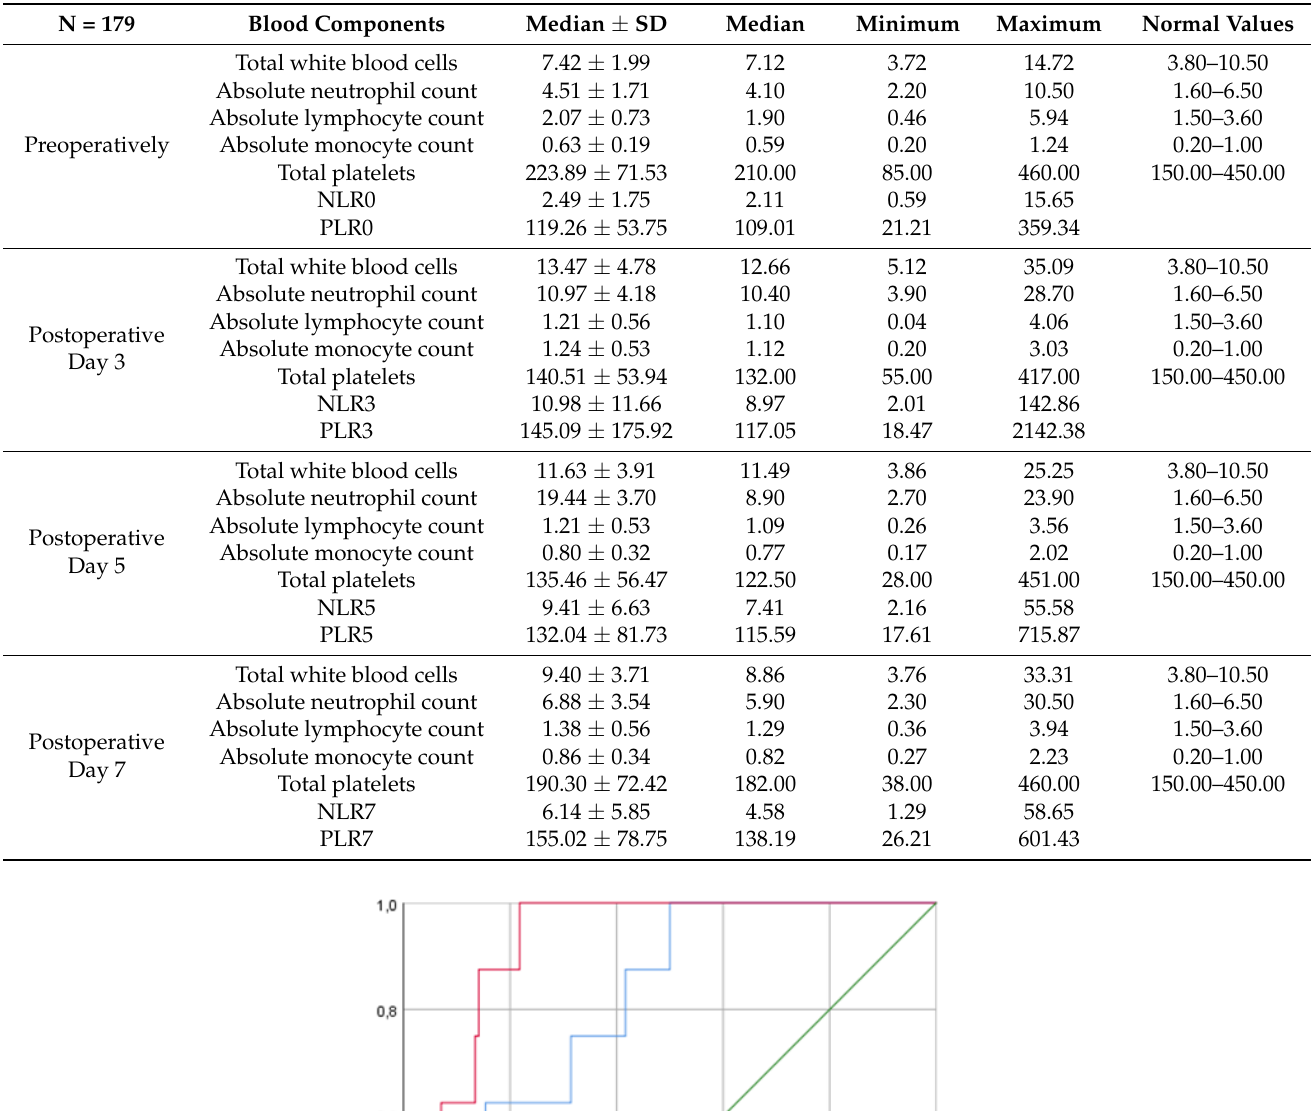
Table 2. Data from all the patients included in the study regarding white blood cells, leucocytes, monocytes, platelets (all expressed in × 10 3 / µ L), neutrophil-to-lymphocyte ratio (NLR), and platelet- to-lymphocyte ratio (PLR) preoperatively and on postoperative days 3, 5, and 7.